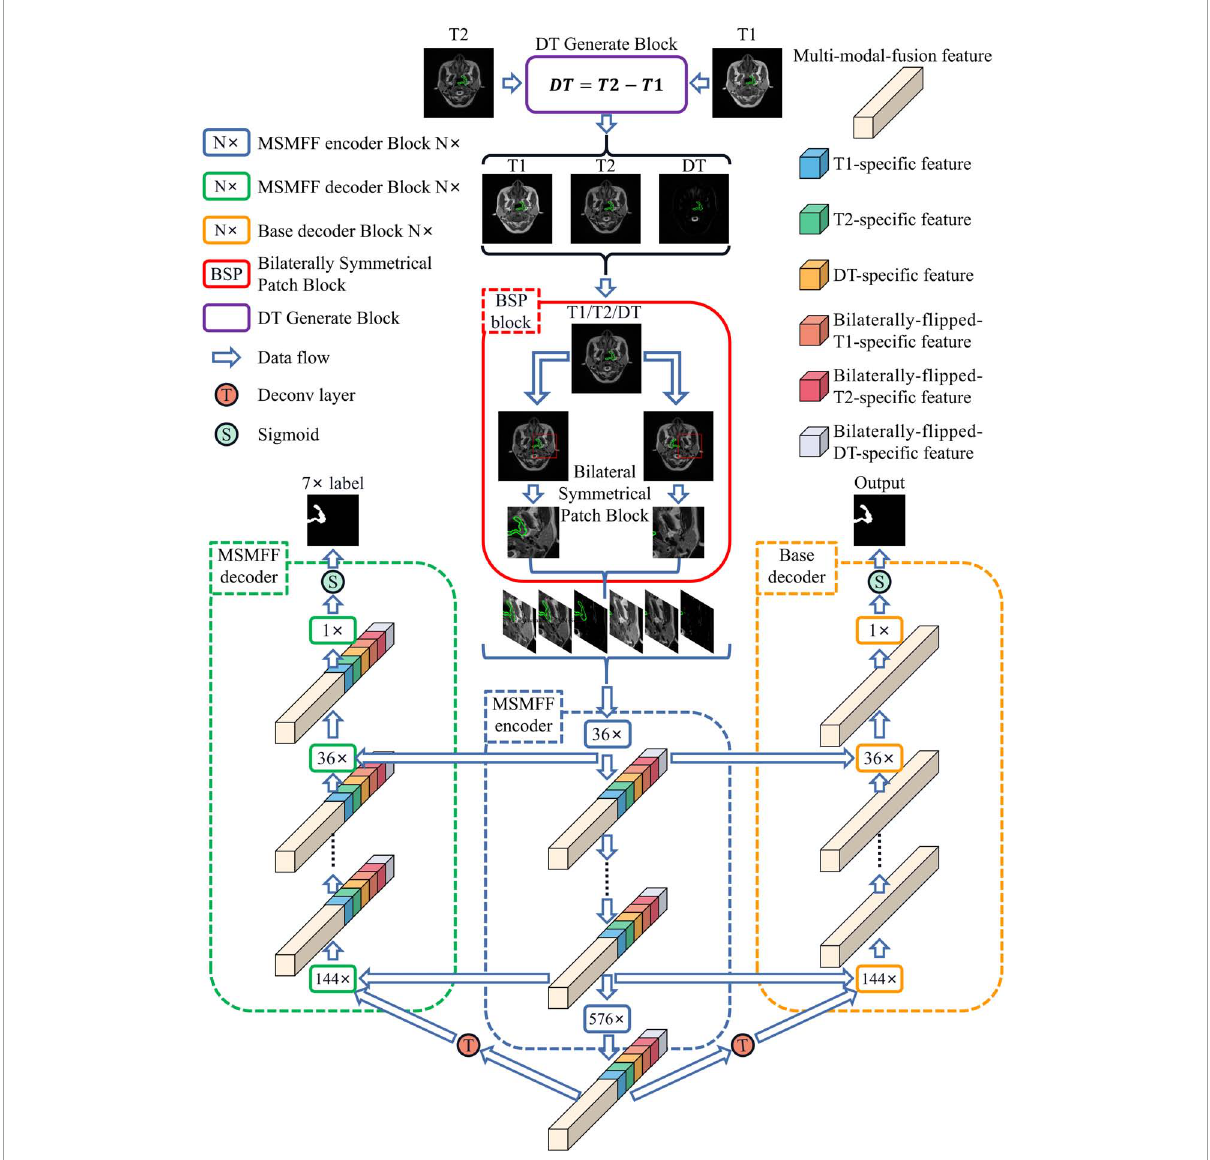
FIGURE1 Architecture of BSMM-Net. The BSMM-Net is composed of DT-generated block, bilaterally symmetrical patch block, MSMFF encoder, and base decoder. The MSMFF encoder represents the combination of MSMFF encoder blocks. The MSMFF decoder is used as a deep supervisor in the training step. The inputs of the MSMFF encoder are preprocessed by the bilaterally symmetrical patch block and DT-generated block. In inference, the final segmentation of BSMM-Net is the output of the base decoder, which is composed of the base encoder